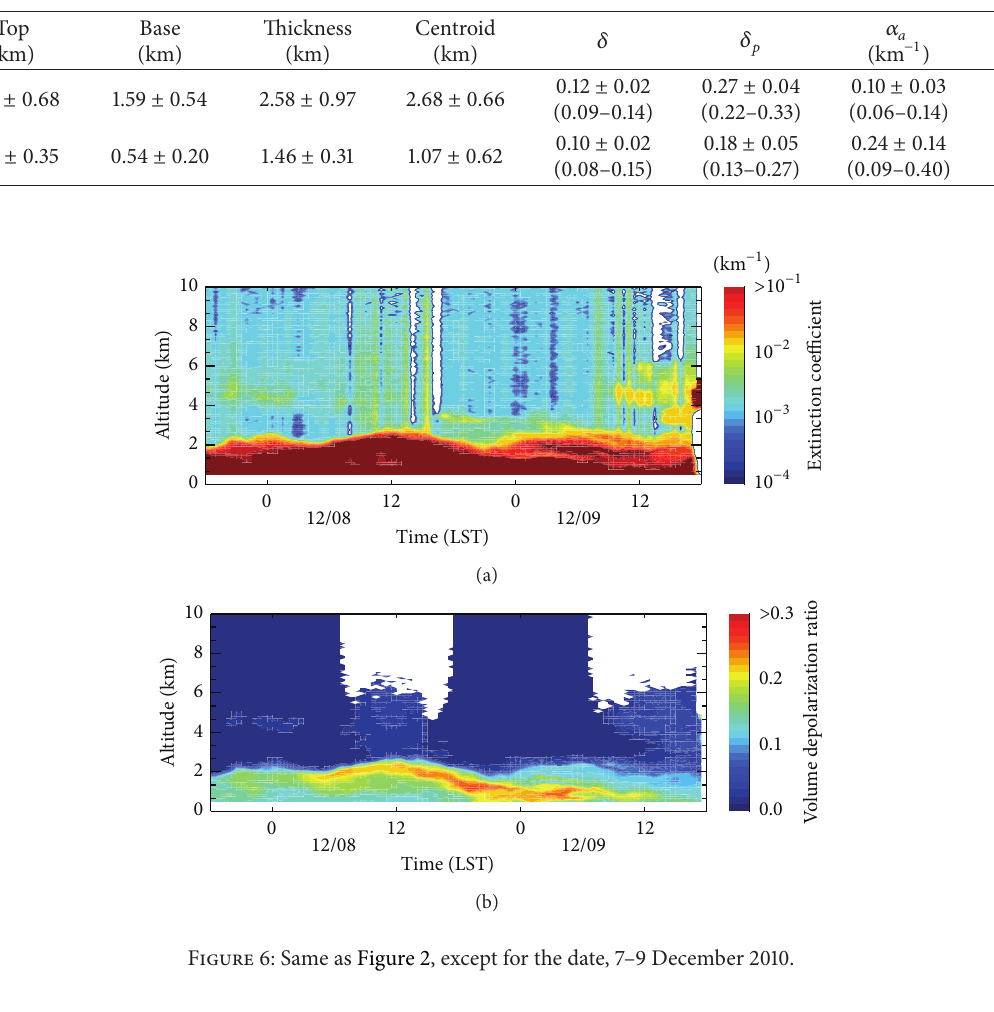
Table 3: Comparison of dust properties over Wuhan during spring and winter. The standard deviations of the mean values are shown. The maximum values and the minimum values of the optical properties are also shown in the parenthesis.